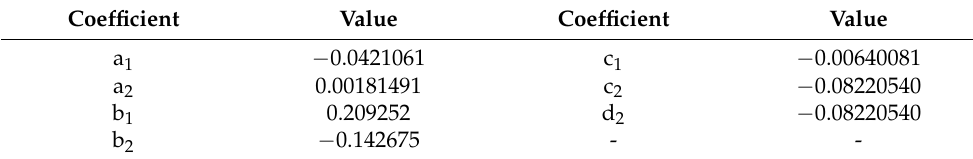
Table A3. Coefficient values of